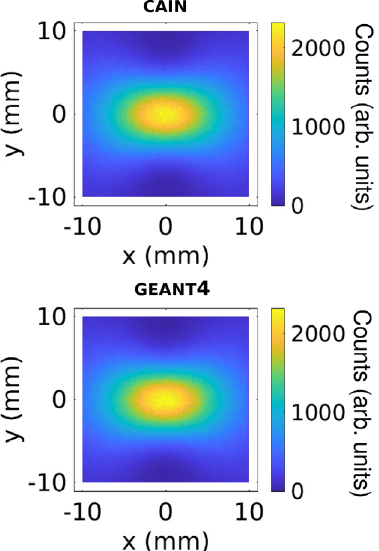
FIG. 8. Intensity spatial distribution at a distance from the IP of 10 m for the EGammaS-GBS photon beam simulated with CAIN and GEANT 4 . The axis scale was set to highlight the most significant part of the